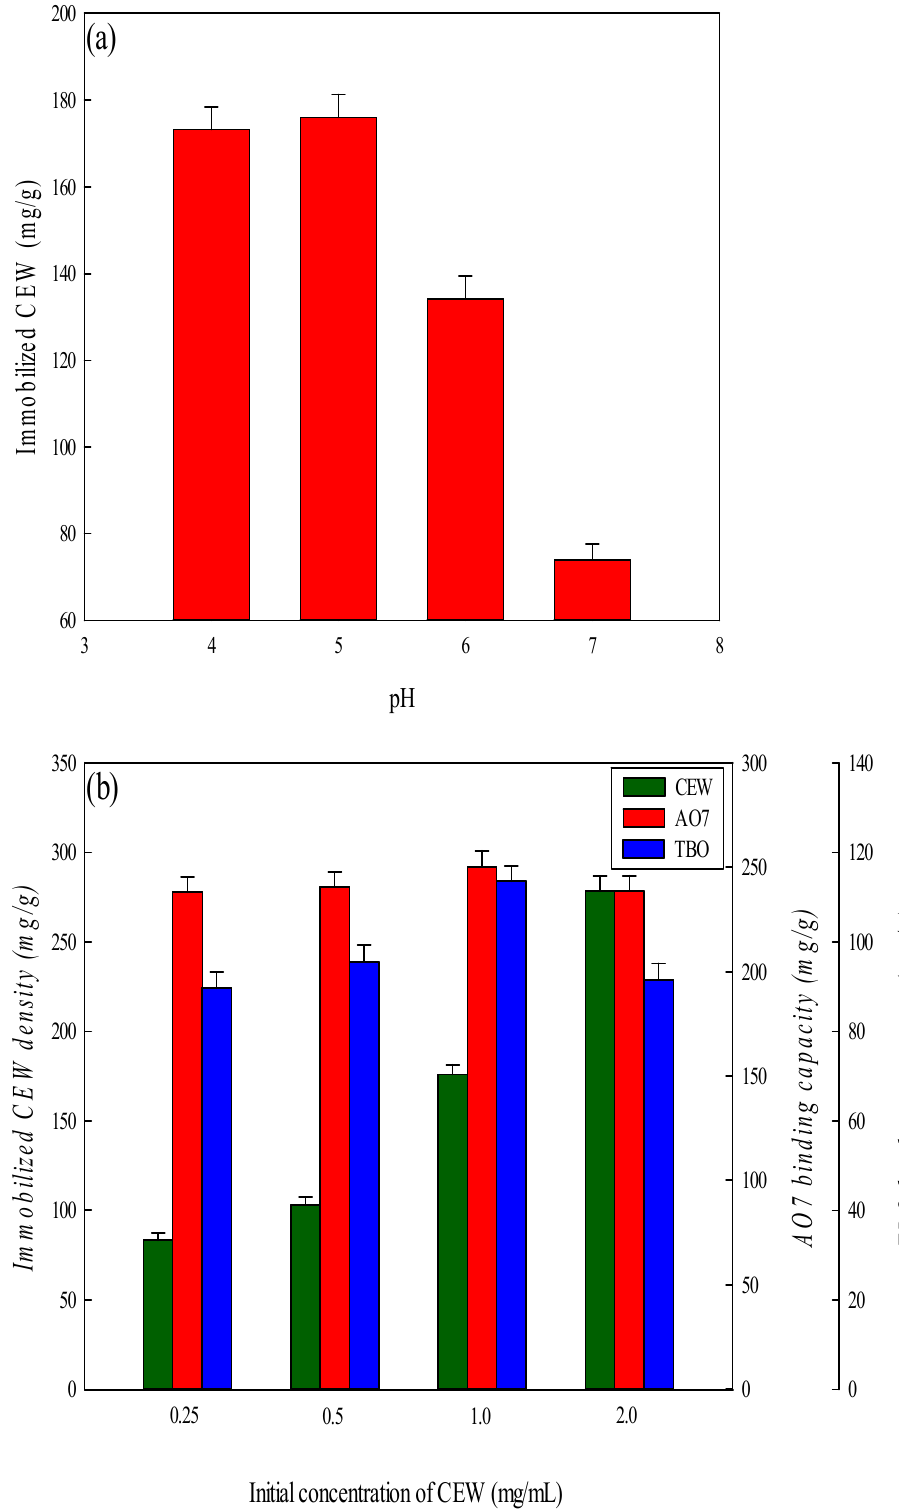
Figure 5. ( a ) Effect of coupling pH on the amount of CEW (1.0 mg/mL) immobilized onto the P-COOH-CS nanofiber membrane. ( b ) Effect of loaded CEW concentration on the CEW immobiliza- tion density on P-COOH-CS-CEW nanofiber membrane and the TBO binding capacity. Operating conditions: P-COOH-CS-CEW nanofiber membrane (~0.03 g), CEW concentration (0.25–2.0 mg/mL, 5 mL, pH 5, 3 h, 100 rpm).